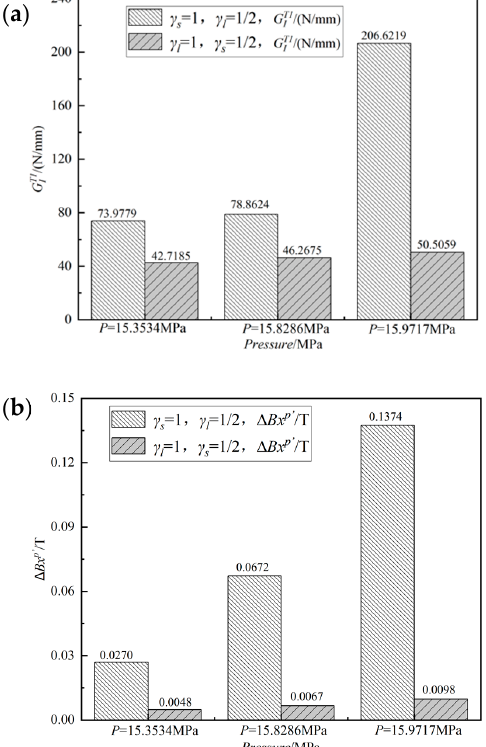
T 1 − γ − γ s , Figure 20. Variations of 𝛾 (cid:3010)(cid:3021)(cid:2869) − 𝛾 (cid:3010)(cid:3021)(cid:2869) − 𝛾 (cid:3043)’ − l , G I I (cid:3039) , 𝐺 (cid:3046) , ( b ) ∆𝐵𝑥